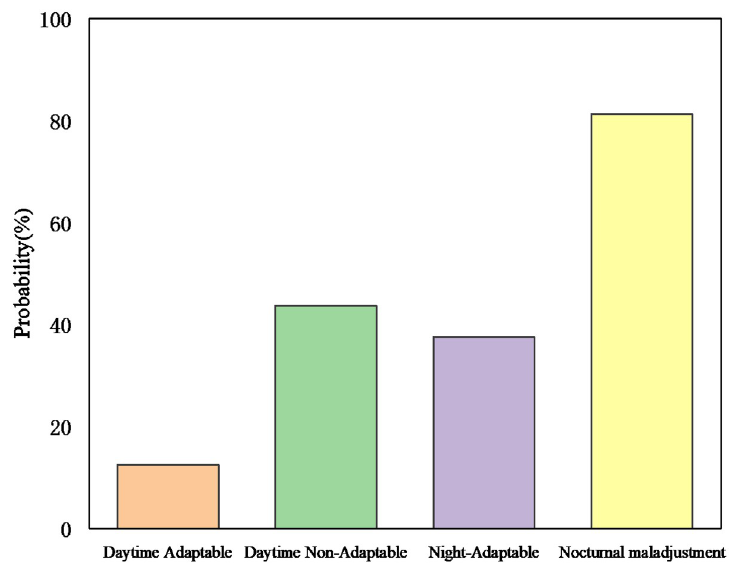
Fig 4. Probability of driver passing yellow light under interaction.